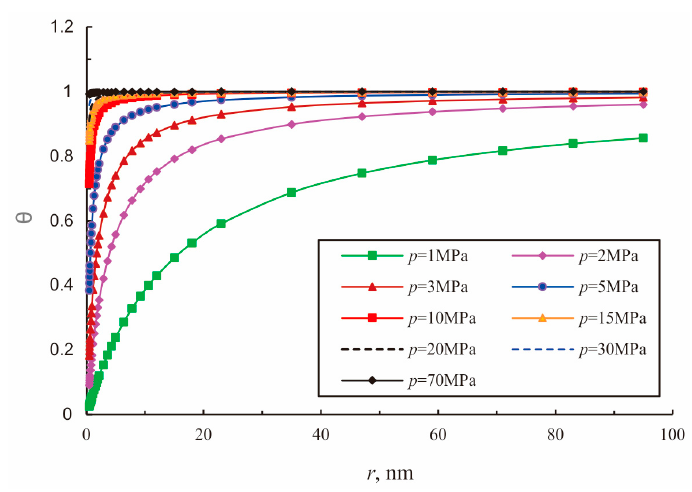
Figure 15. Gas coverage ratio under different pore size and pressure conditions.